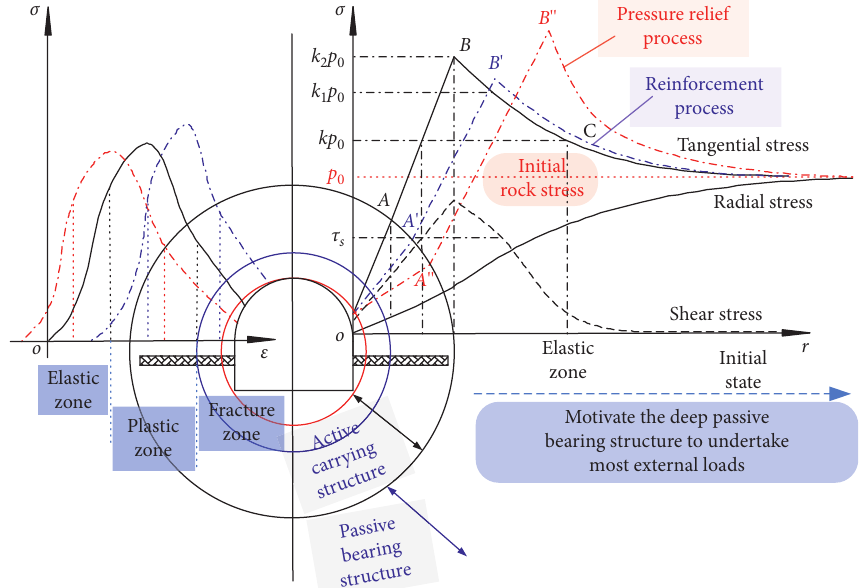
Figure 2: Distribution states of surrounding rock stress and strength features in a